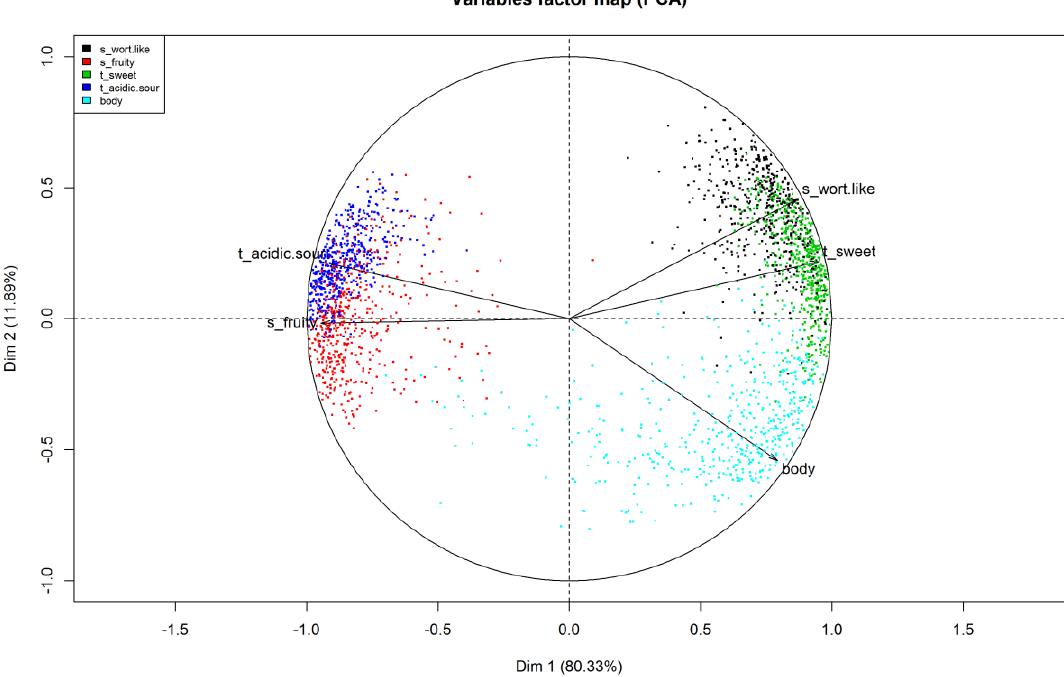
Figure 5. Variables factor map of the principal component analysis (PCA) of the sensory of the final beers. Criteria for descriptors to be included in the PCA was a p value of the F-test of below 0.5. For the descriptors “s_” stands for smell, and “t_” stands for taste.